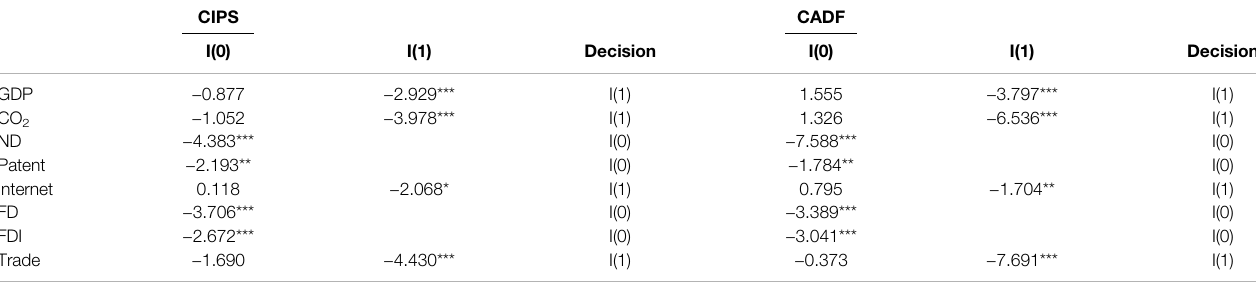
TABLE 2 | Results of panel unit root